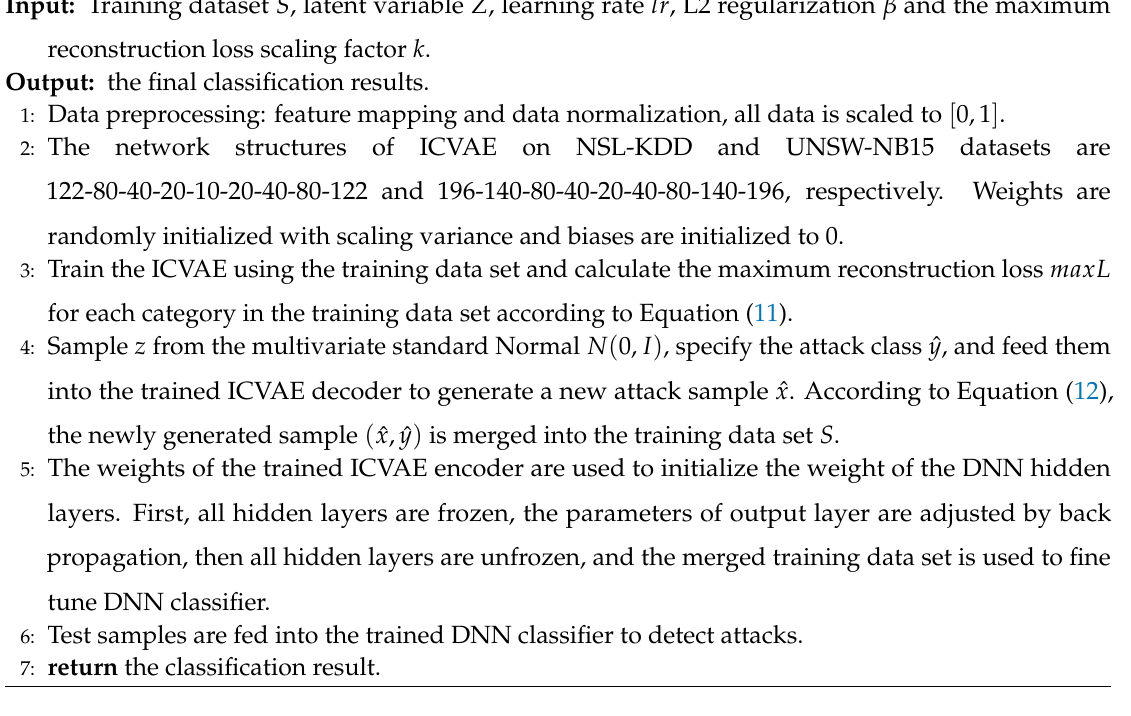
Algorithm 1 Improved conditional variational AutoEncoder (ICVAE)-deep neural network